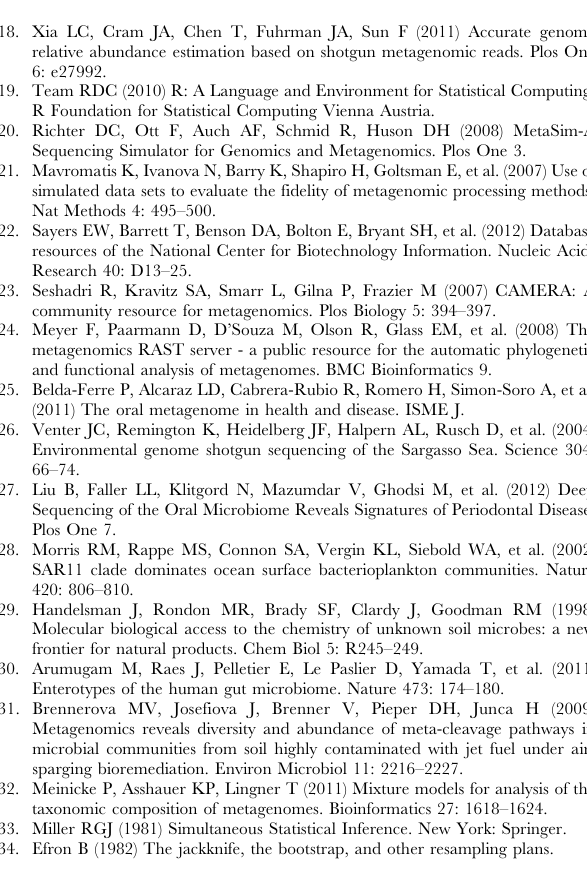
Table S2 Results for simulation study 1 with average read length of 400 bp. The percentage of correctly (TP) and incorrectly (FP) assigned reads out of total 10,000 reads with average read length of 400 bp at different taxonomic ranks using TAMER and MEGAN for simMC and simHC